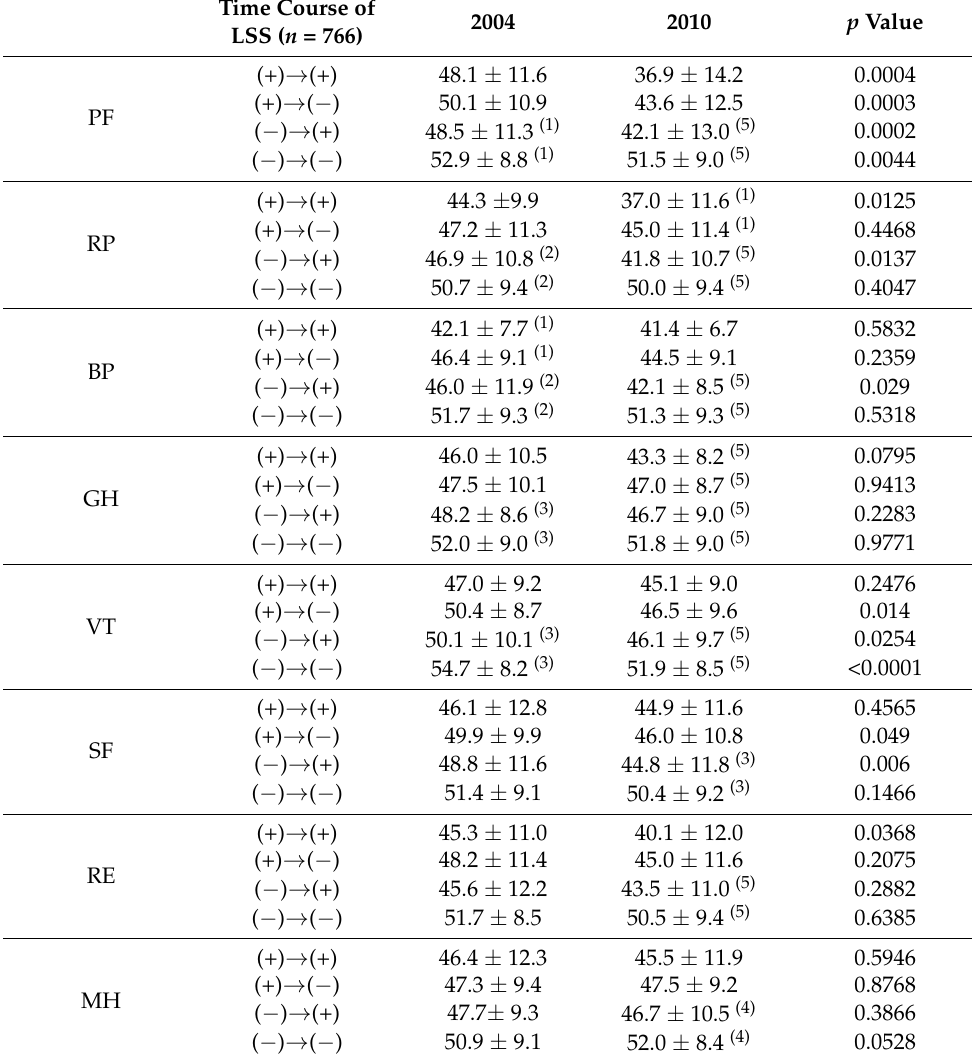
Table 5. Changes in eight domains of the SF-36 of the subjects with/without LSS